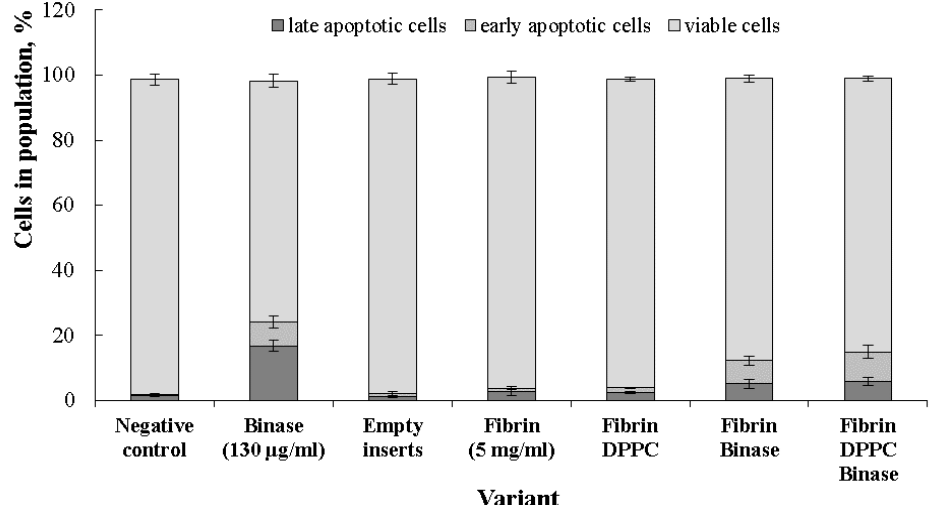
Figure 7. Apoptosis induction of HuTu80 cells by pure substances (binase, fibrin) and three variants of composite gels after 24 h of monolayer treatment by substances released from inserts into cultivation medium with growing cells. Non-treated cells were taken as negative control.